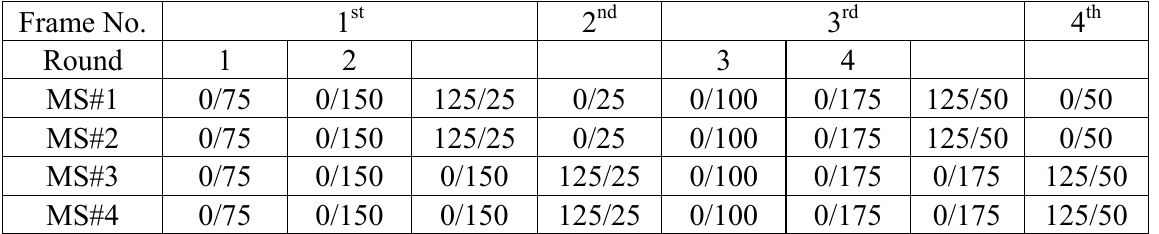
Table 1. Updated Deficit Counter for DRR (Transmitted Packet Size/Deficit Counter) [10].